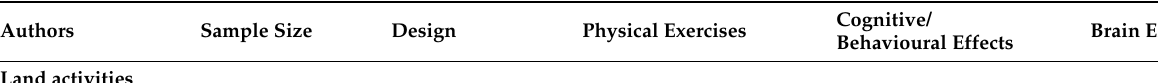
Table 2. Studies on land activity effects on cognitive functions and neural substrates of healthy human